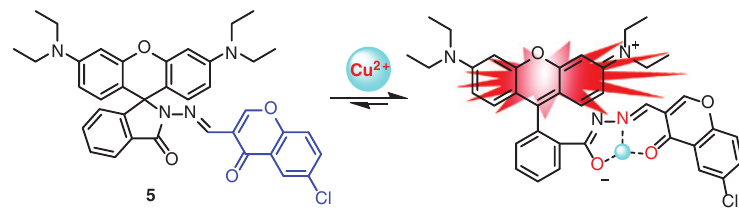
Figure 7: Recognition mechanism of probe 5 with Cu 2 +